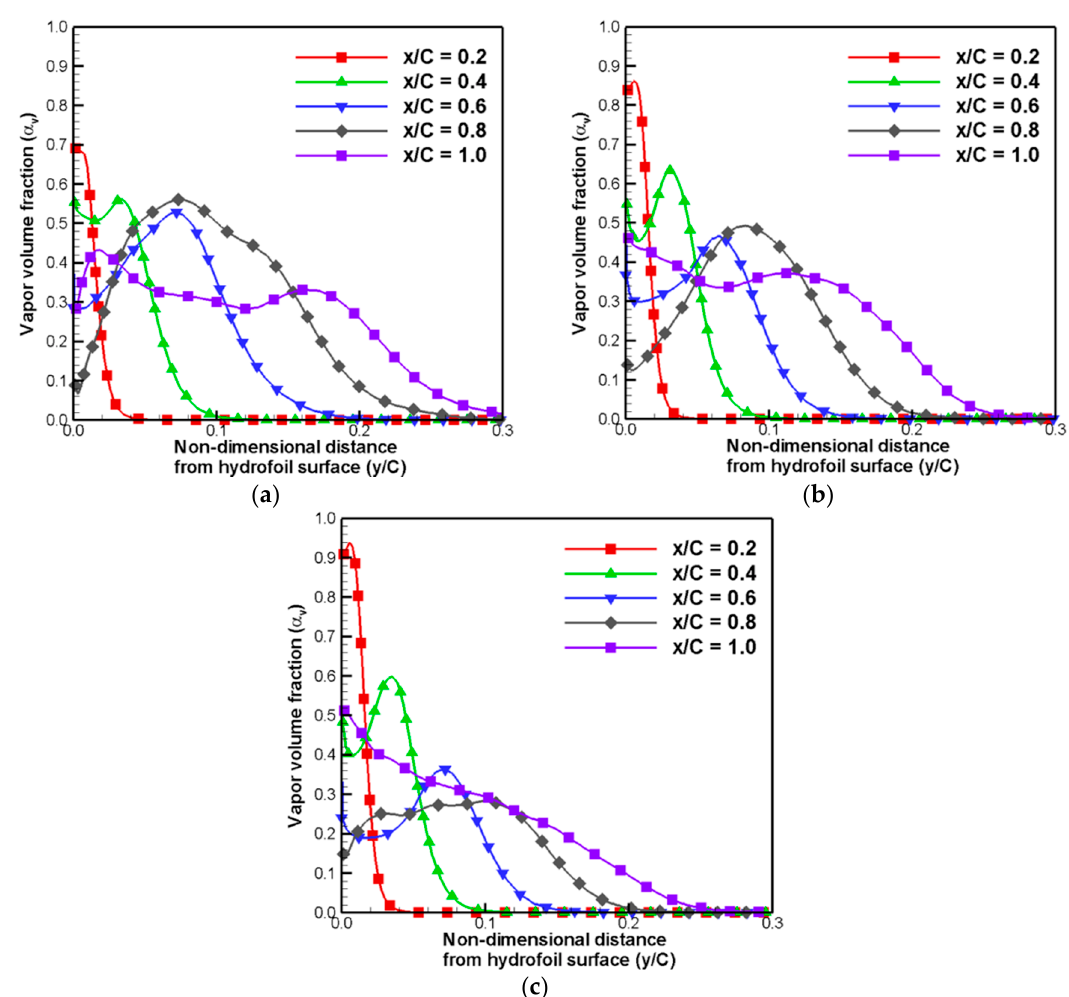
Figure 10. Time-averaged vapor volume fraction distribution at five stream-wise locations: ( a ) viscous lagging; ( b ) full viscous; and ( c ) thin-layer cases.